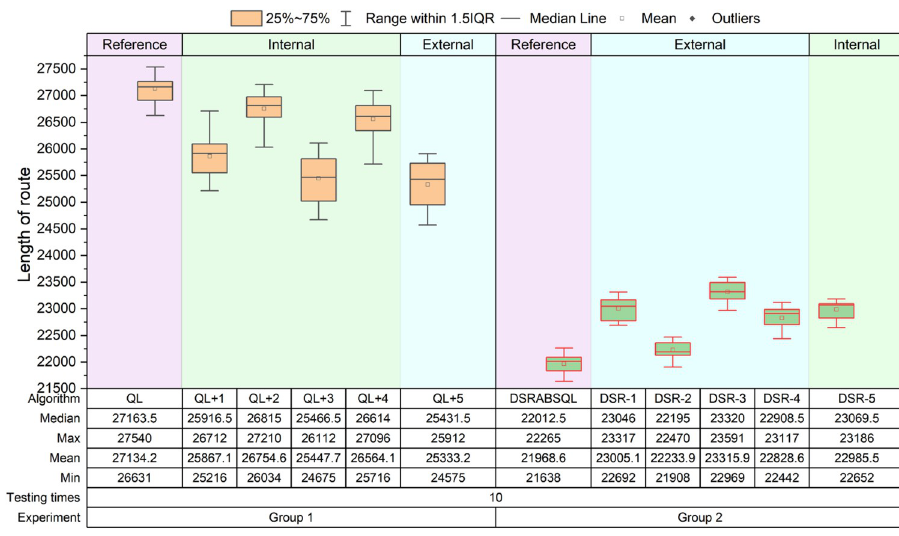
Fig 14. Boxplots obtained by testing fl1400 for 10 times by each